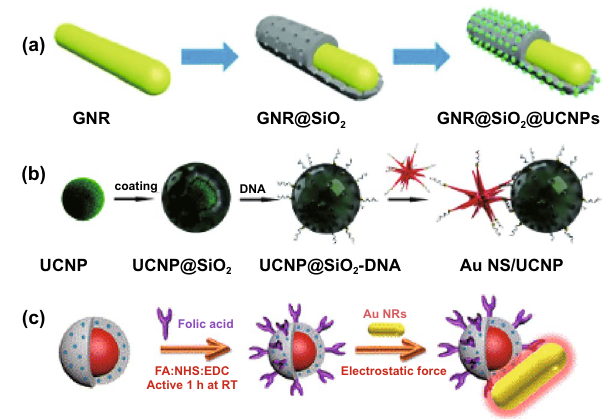
Fig. 17 A different approach to fabricate the hybrid system based on plasmonic NPs, PS molecules and UCNPs interactions: a formation of core/satellite shape, reproduced from Ref. [255] with permission from Royal Society of Chemistry, b DNA hybridization, reproduced from Ref. [259] with permission from Royal Society of Chemistry, and c electrostatic attraction forces, reproduced from Ref. [241] with permission from American Chemical